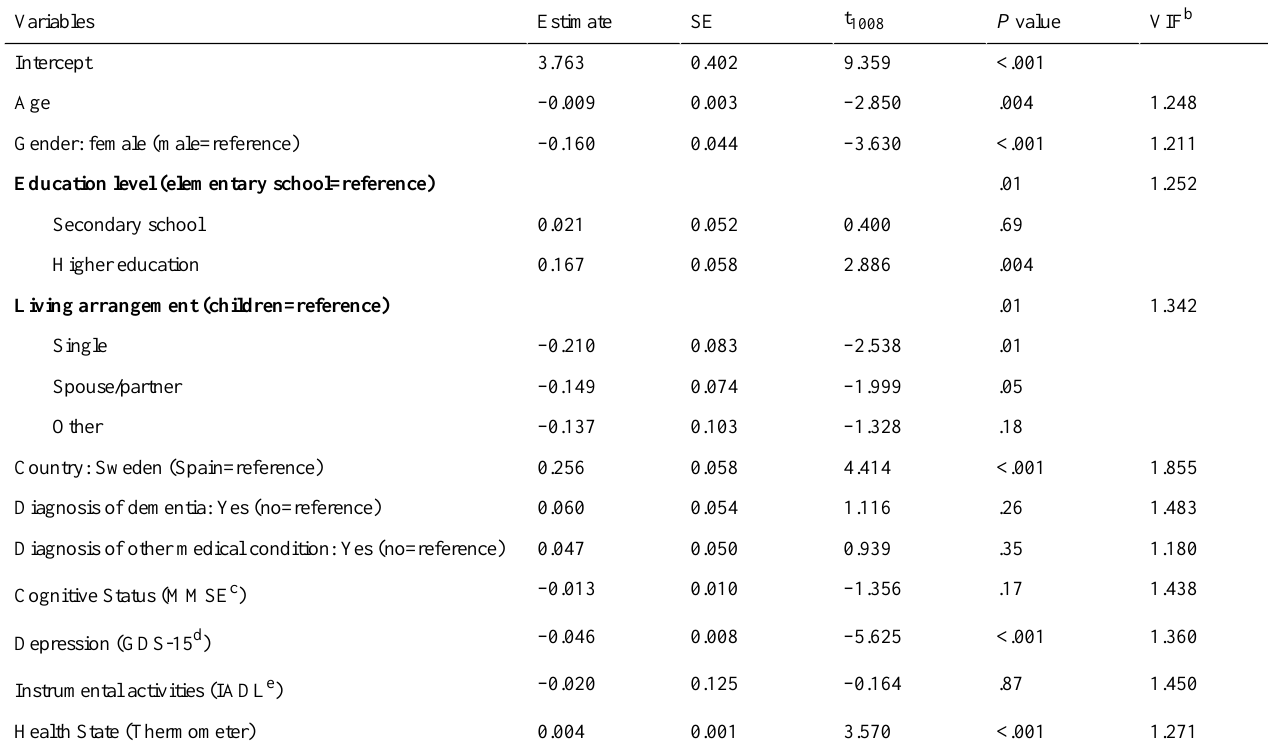
Table 3. Multivariate linear regression model a of factors associated with technophilia in people with dementia/mild cognitive